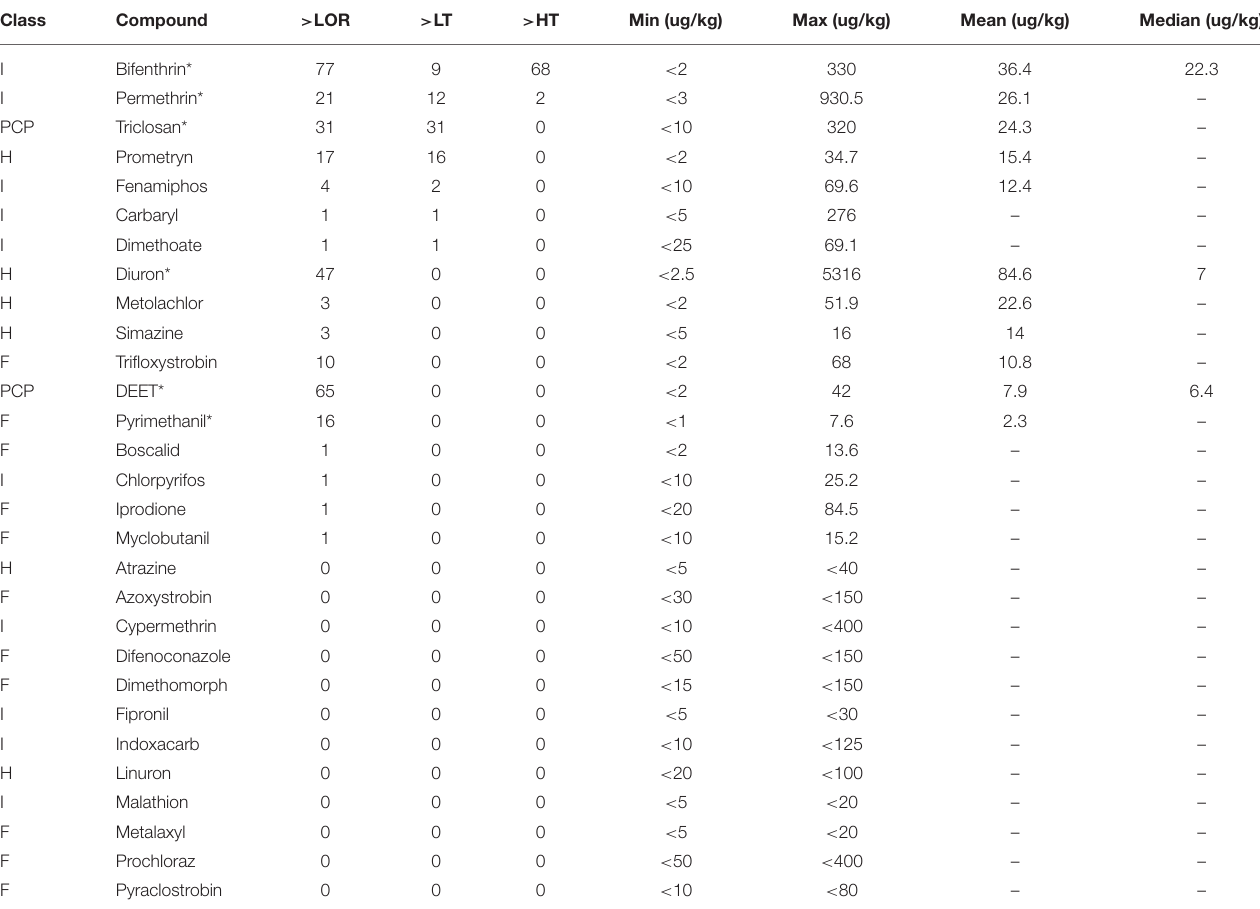
TABLE 1 | Occurrence of pesticides in wetland sediments.